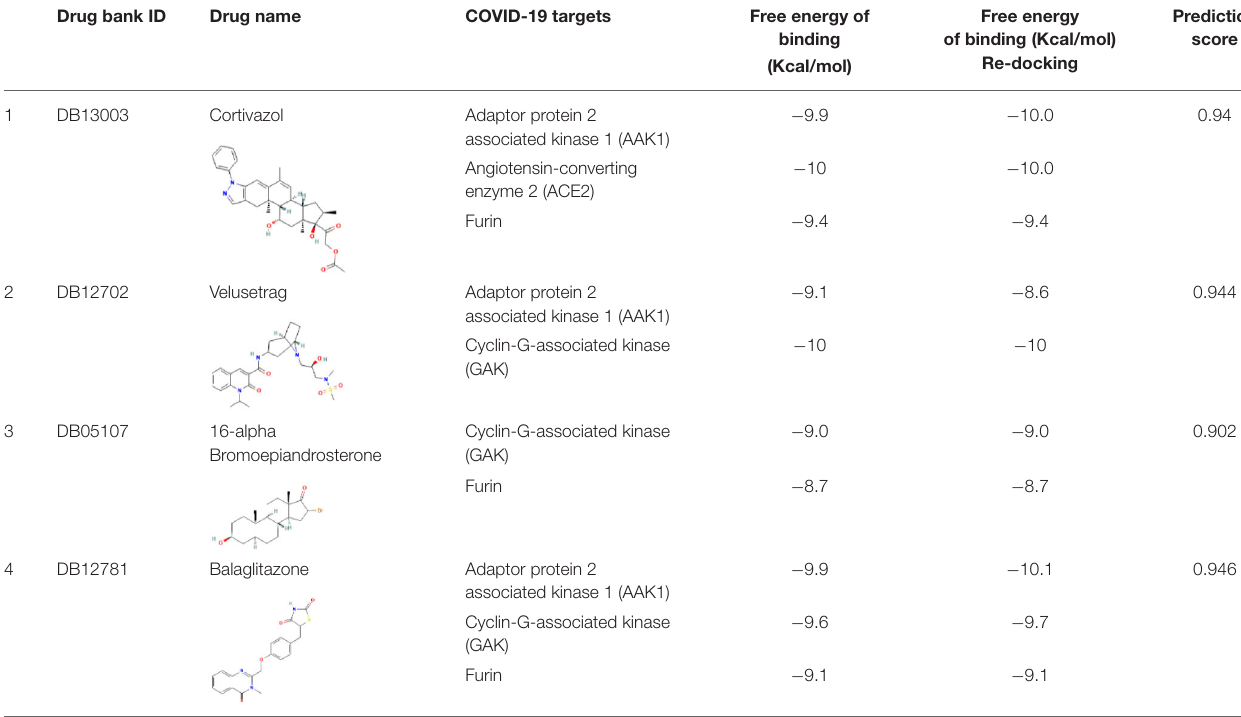
TABLE 5 | Finally suggested four drug candidates for COVID-19 with their target information. Drug bank